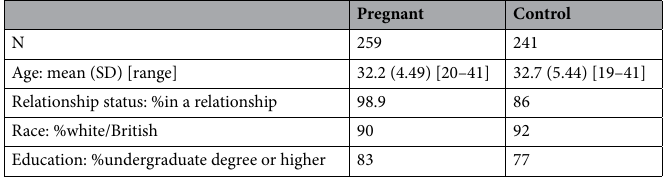
Table 2. Demographic information for the whole sample.